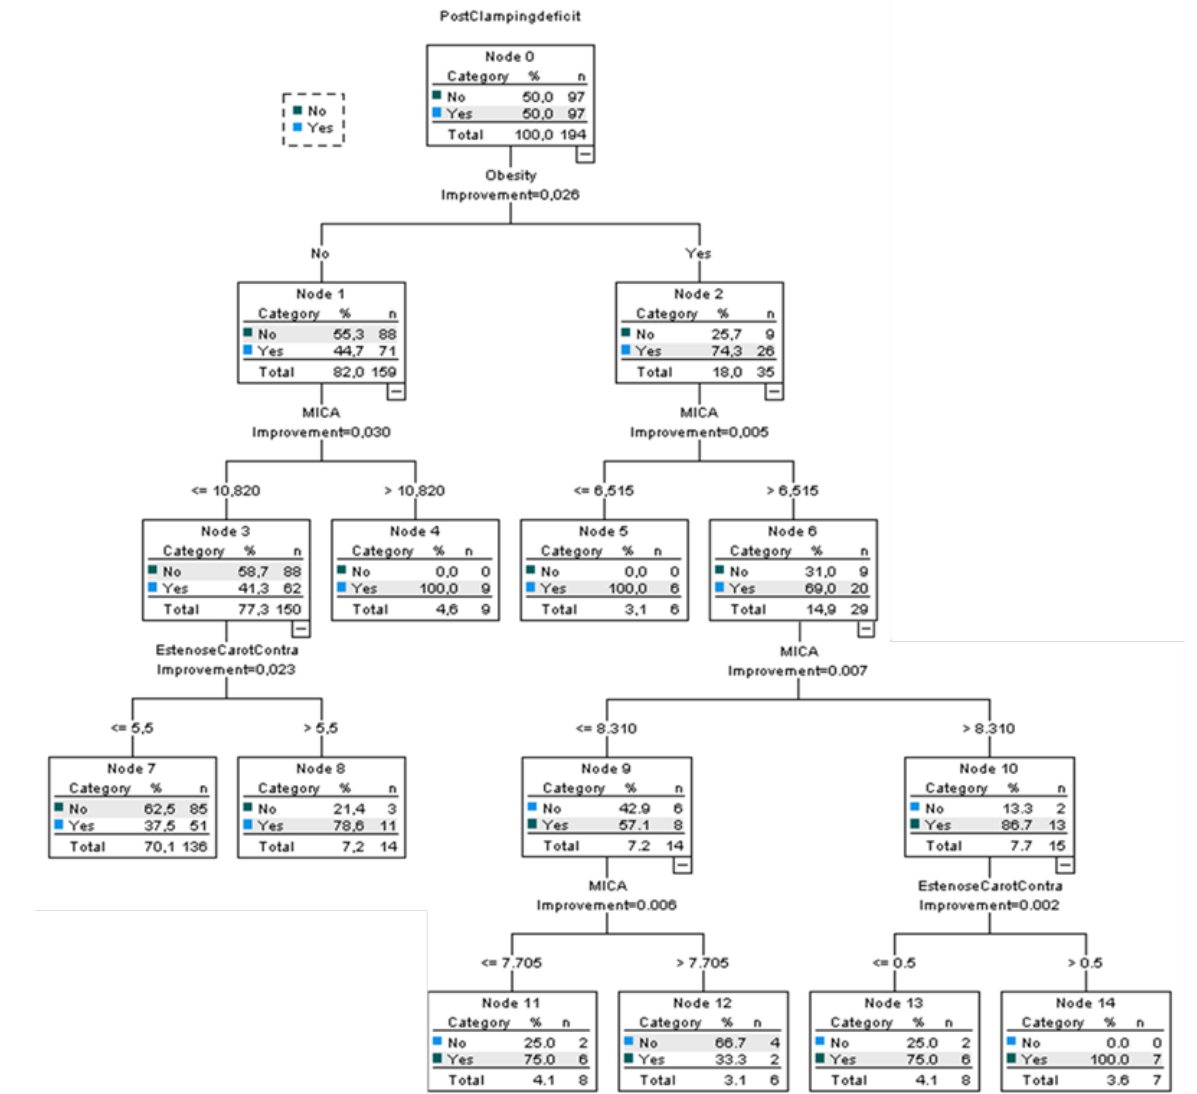
Figure 3. Classification and regression tree (CRT). The manifestation of IND was a dependent variable, while the presence or absence of a diagnosis of obesity, the degree of ipsilateral and contralateral stenosis, and the preoperative MICA score were the independent variables. Parent node = 10 cases; child node = 5 cases; maximum tree depth = 5; overall percentage = 69.1%.